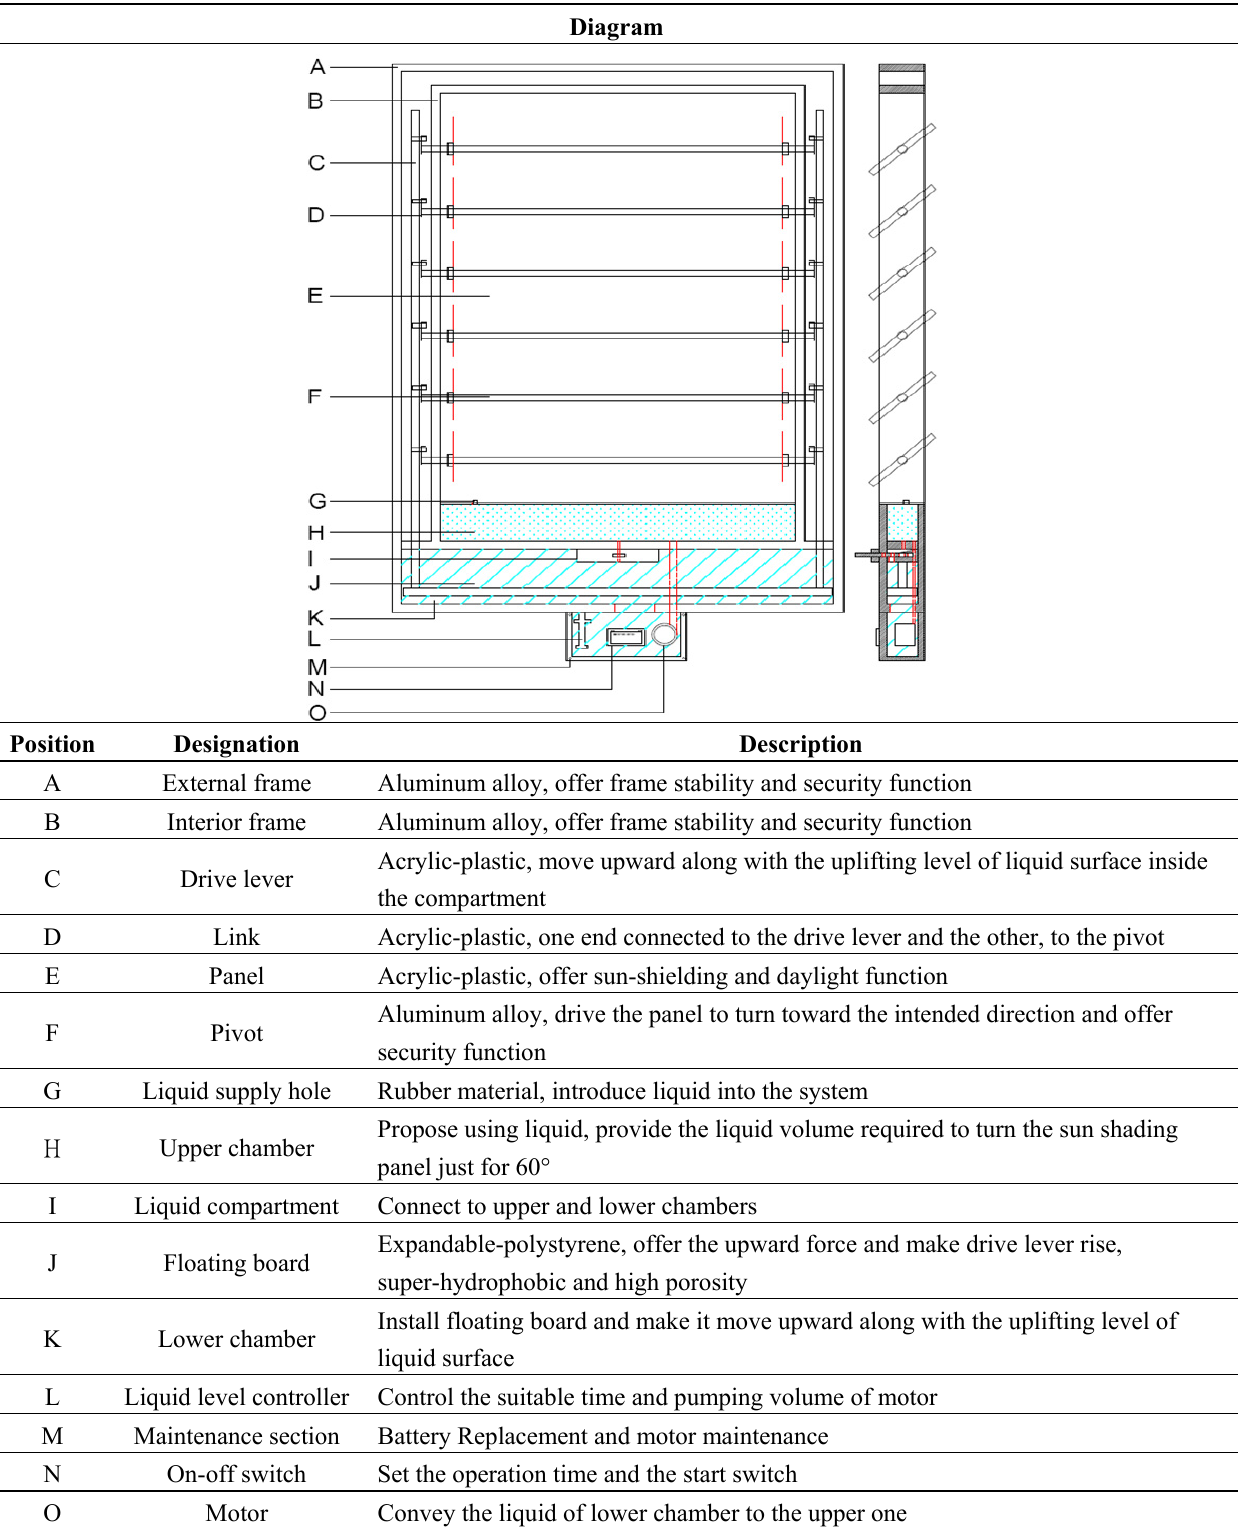
Table 1. Summary of materials selection and function.